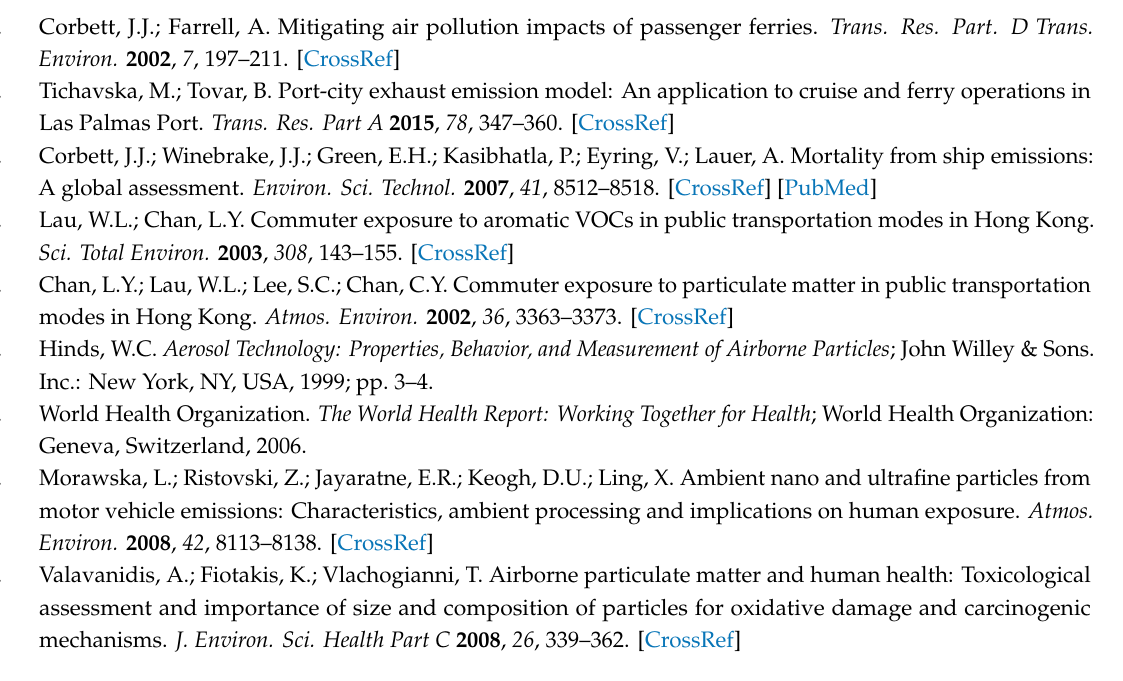
Figure S1: The location of the piers, Figure S2: Polar plots of analysed air pollutants, Figure S3: Air Quality monitoring stations and the piers, Figure S4: Comparison of Thermo pDR 1200 and Thermo Partisol FRM sampler PM 2.5 measurements, Table S1: The ferry characteristics, Table S2: Ferry activity and external emission sources at the piers, Table S3: The mean concentrations in fast ferry and car ferry in the monthly basis, Table S4: The median concentrations in fast ferry and car ferry in the monthly basis, Table S5: The mean concentrations at the pier in the monthly basis, Table S6: The median concentrations at the pier in the monthly basis, Table S7: Exposure concentrations of PNC, BC and PM2.5 (median ± std) for ferry and pier, Table S8: Exposure per / kilometer for PNC, BC and PM 2.5 . Table S9: Monthly average of meteorological